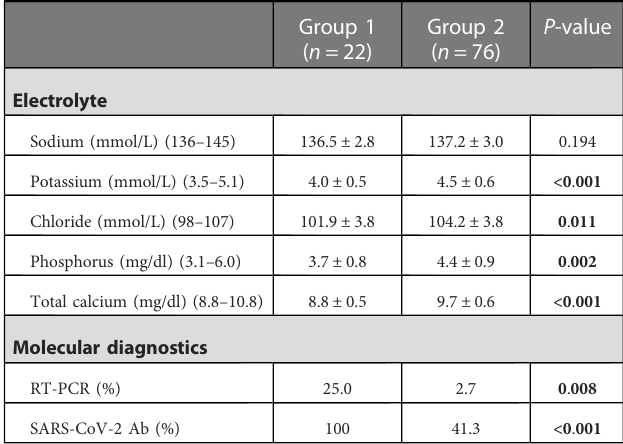
TABLE 1 Demographic and clinical characteristics and laboratory fi ndings of MIS-C and KD.